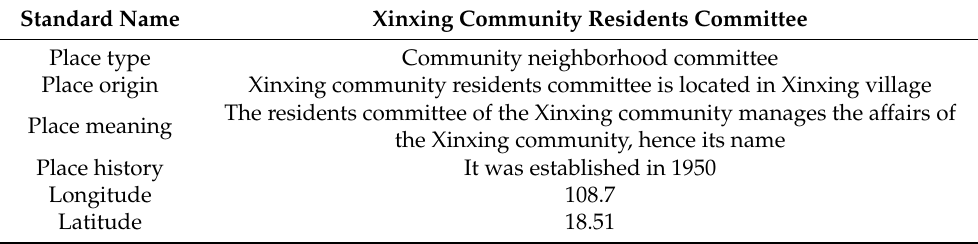
Table 1. Example of place name information